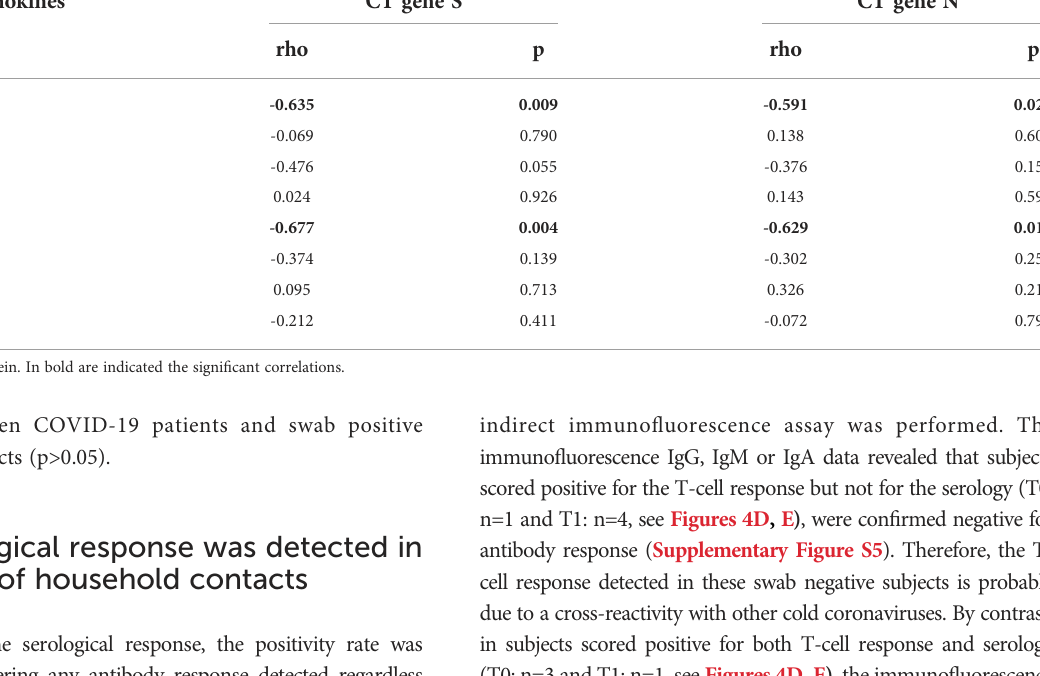
TABLE 3 Correlations between plasmatic cytokines/chemokines and RT-PCR cycle threshold (CT) values in swab-positive subjects.